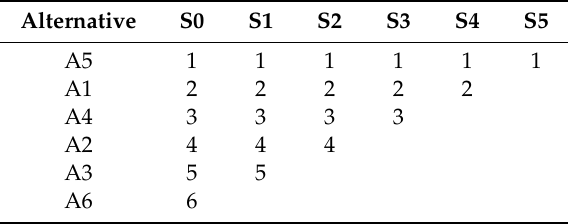
Table 2. The ranking of the alternatives in